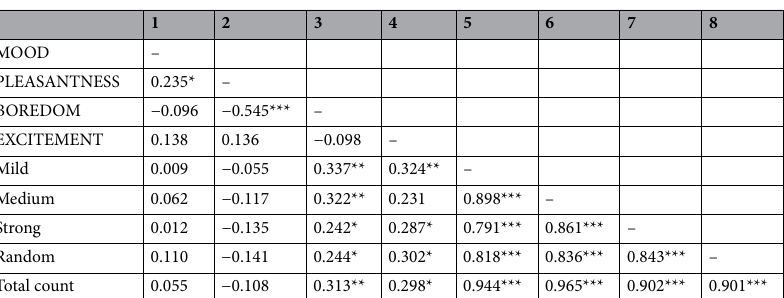
Table 1. Spearman’s rank-based correlations between mood change, ratings of the thinking period, and counts of self-administered shocks during the thinking period. * p < .05, ** p < .01, *** p <